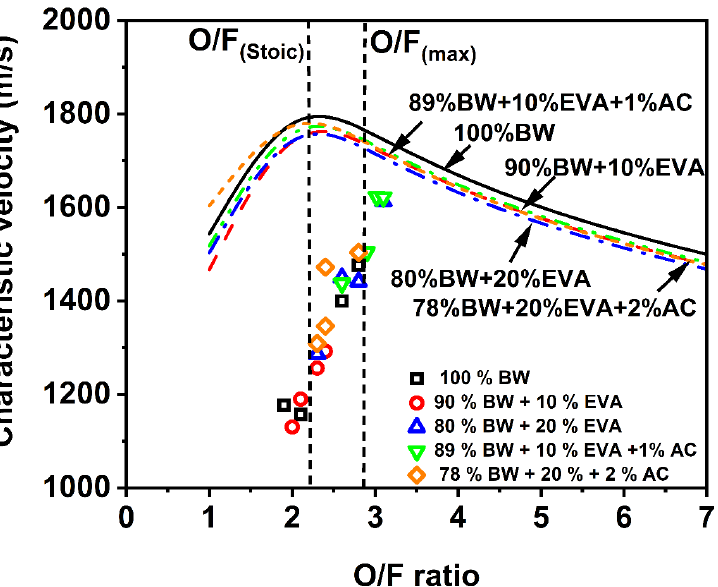
Figure 10. Characteristic velocity variation vs. O/F ratio for prepared fuels (lines and symbols are theoretical and experimental values, respectively).